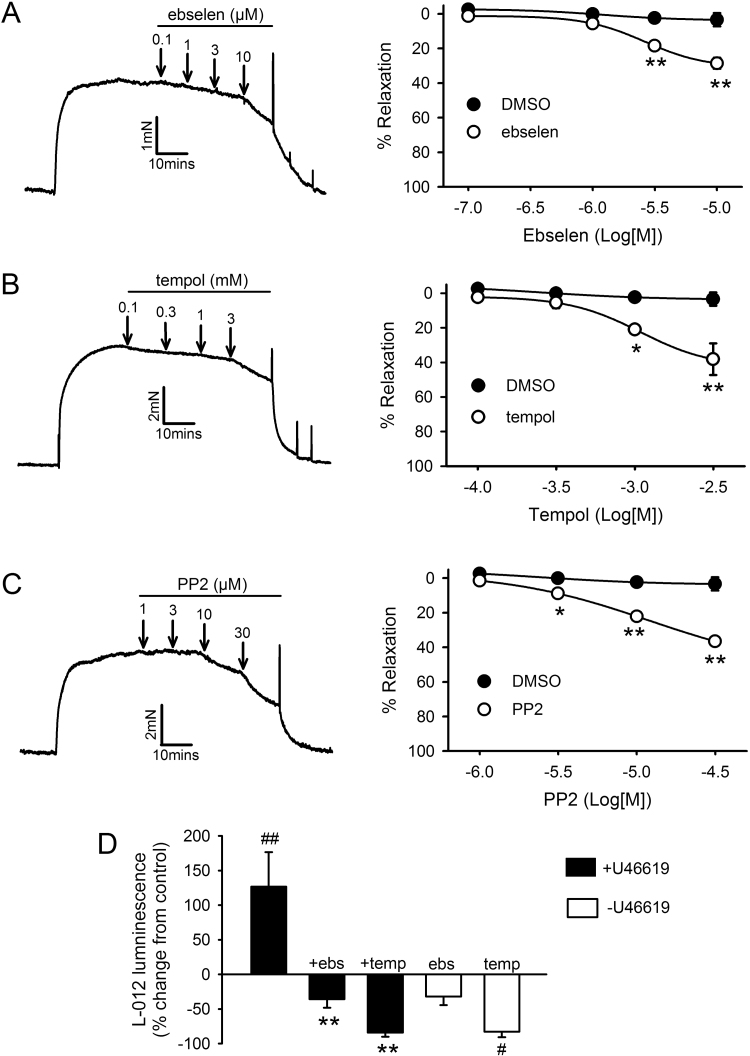
Effects of U46619, antioxidants and SrcFK inhibition on contraction and ROS production. A-C: Concentration-dependent relaxation responses to ebselen (A, n=8), Tempol (B, n=7) and PP2 (C, n=6) in IPA pre-constricted with 100 nM U46619. Left panels: representative traces with arrows indicating where each dose was added. Right panels: mean effects of inhibitors plotted against DMSO vehicle control (n=5). *P<0.05, **P<0.01 vs. DMSO control (2-way ANOVA). D: Effect of ebselen (10 µM) or Tempol (3 mM) on U46619-induced ROS production (15 min, 100 nM, solid bars) or on basal ROS production (open bars) in PASMC, measured by L-012 chemi-luminescence. #P<0.01 vs. control; ##P<0.001 vs. control; **P<0.001 vs. U46619 alone (2-way ANOVA, n=10).